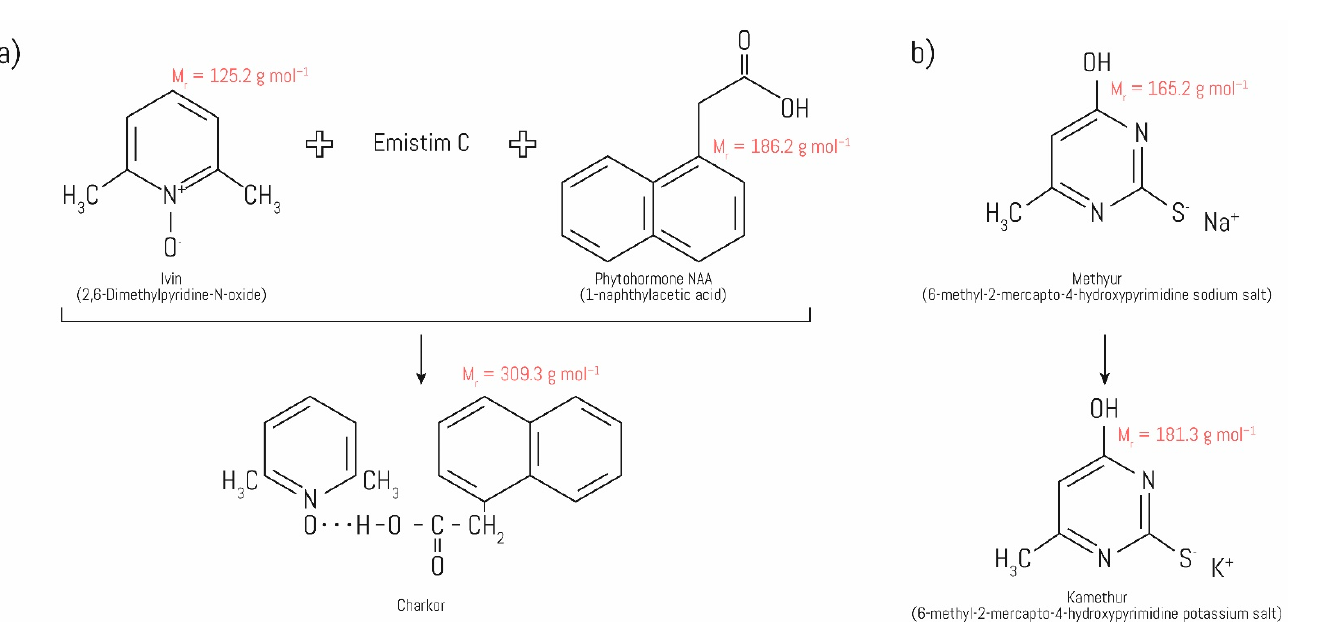
Figure 1. Chemical structure of Charkor ( a ) and Kamethur ( b ).